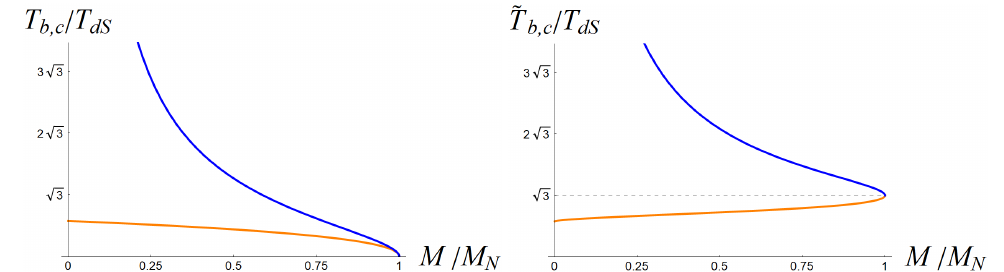
= 1 / 2 π L vs. unitless mass parameter Figure 2: Temperatures T in units of T b , c dS M / M , where we have set d = 4. The black hole temperature is shown in blue N and the cosmological horizon temperature in orange. The left figure shows the tem- = κ b , c peratures T , where the surface gravities are defined with respect to the time b , c 2 π translation Killing vector ξ = ∂ . The right figure shows the Bousso-Hawking temper- t = ˜ κ b , c atures ˜ T , which are normalized with respect to a free-falling static observer, b , c 2 π cf. (17). On the left the temperatures go to zero in the Nariai limit, whereas on the (cid:112) 3 = right the Nariai temperature is finite T N 2 π L